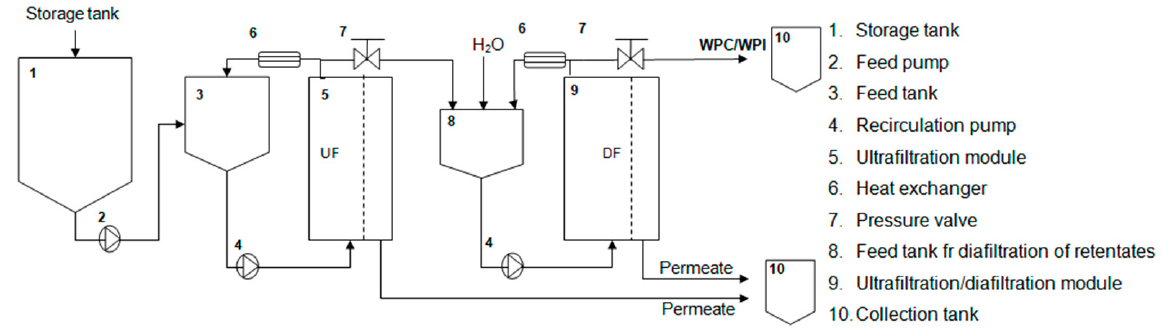
Figure 4. Scheme for the installation of membrane processes to recover GCW and SCW for a small/medium size cheese dairy.